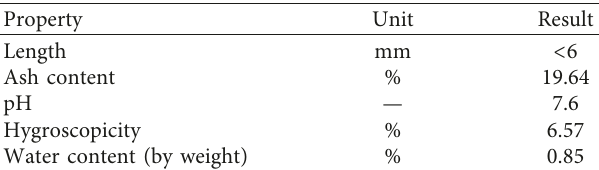
Table 6: Properties of lignin fibers.